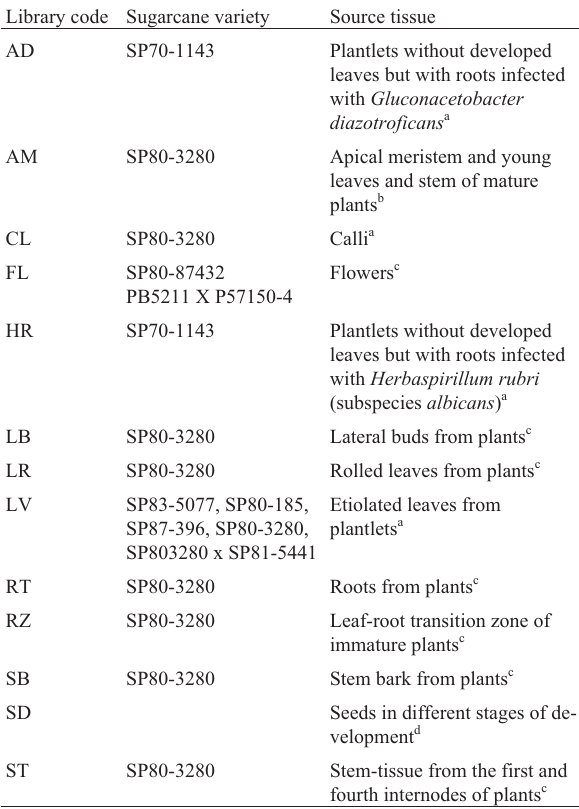
Table I - Library codes of the sugarcane source tissues and varieties used in this